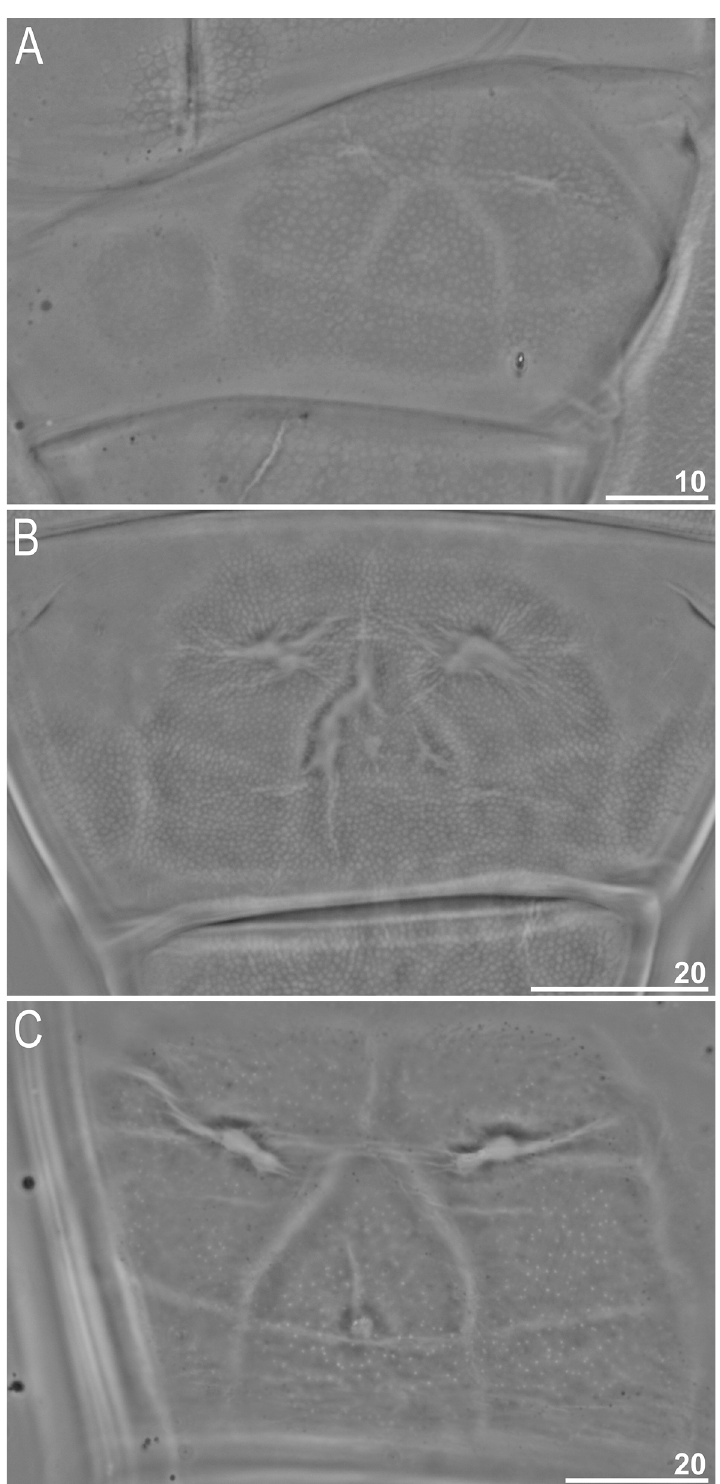
Figure 2. Dorsal cuticle sculpturing of Milnesium decorum sp. nov. seen in PCM: ( A ) hatchling with a clearly visible reticulation (paratype); ( B ) juvenile with a visible reticulation (holotype); ( C ) adult female with clearly visible pseudopores but unidentifiable reticulation (paratype). All scale bars in